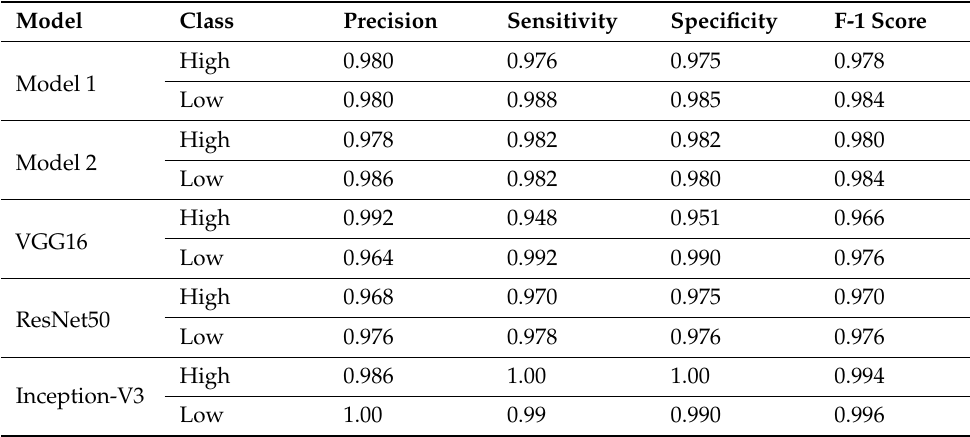
Table 2. 5-fold cross-validation classification report per